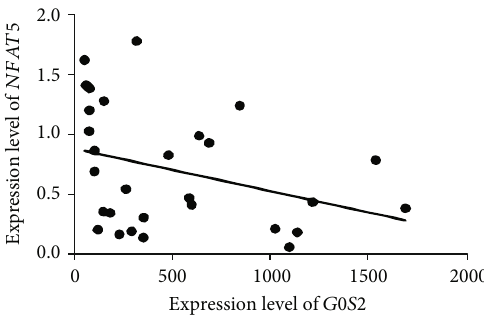
Figure 6: The correlation analysis between the expression level of G0S2 and NFAT5. The y -coordinate represents expression level; each dot represents an individual expression result of G0S2. The oblique line is the fi tting curve of expression level of NFAT5. Figure 7: The expression of G0S2 in the PMBC from MG patients before and after treatment with tacrolimus therapy. ∗∗∗ p < 0 : 01 . The y -coordinate represents expression level; each dot or blocks represents an individual expression result of